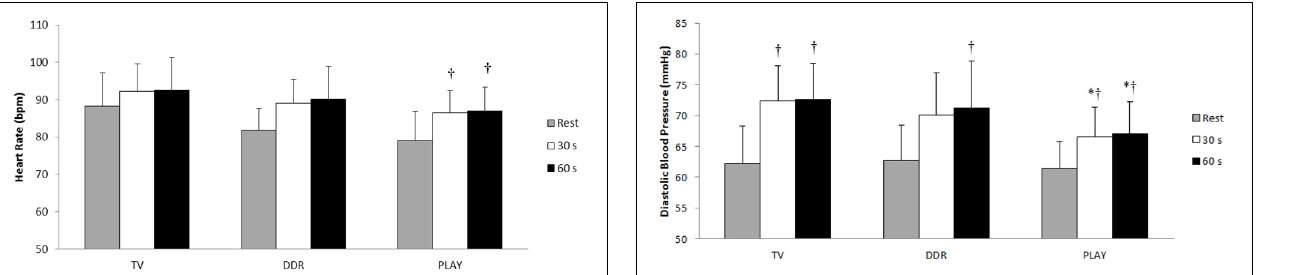
FIGURE 2 | Heart rate responses at the 30th and 60th s during Cold Pressor Test in each session. † p ≤ 0 . 05 in relation to pre-exercise rest.